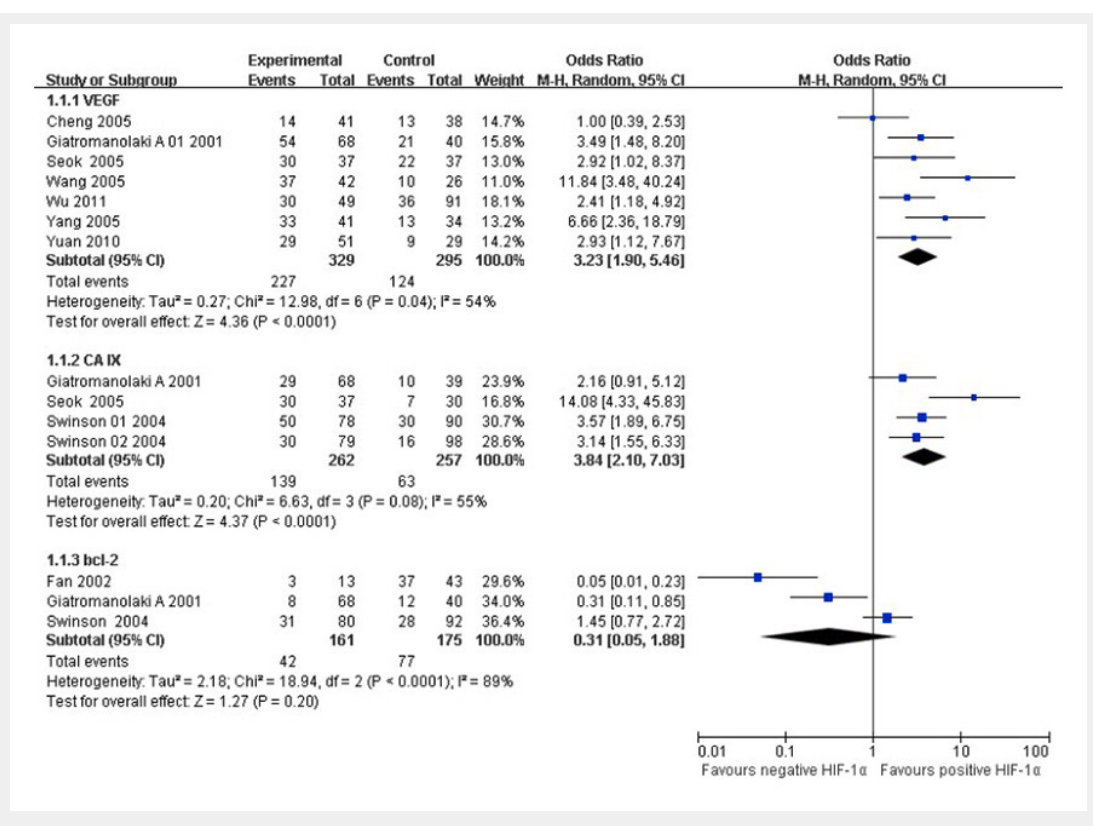
Figure 2 Forest plot of VEGF, CA IX and bcl-2 positive expression in positive and negative HIF-1α tumour tissues, respectively (Giatromanolaki A 01 2001: Giatromanolaki A 2001 [14], Giatromanolaki A 2001: Giatromanolaki A 2001 [15], Swinson 01 2004: pCA IX, Swinson 02 2004: mCA IX).